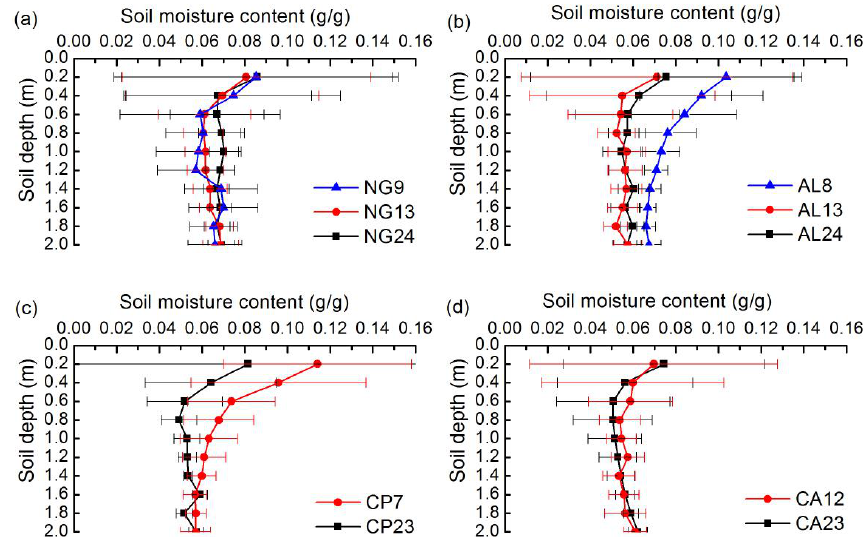
Fig. 6. Comparison of temporal-averaged shallow soil moisture content (SMC) in different slope gradients. Note: NG represents native grassland; AL represents alfalfa; CP represents Chinese red pine; CA represents Chinese arborvitae. The number of samples of shallow soil moisture content was 26. The last number refers to slope gradient. For example, NG9 refers to native grassland with slope gradient of 9 ◦ , NG13 to natural grassland with slope gradient 13 ◦ , NG 24 ◦ to natural grassland with slope gradient 24 ◦ .